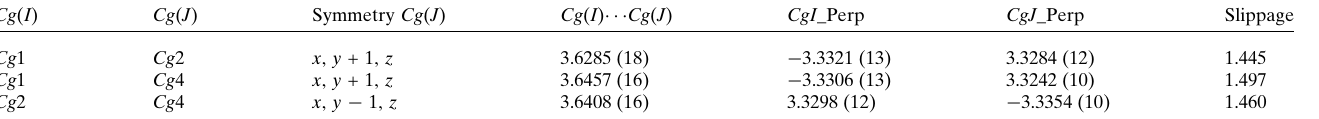
Table 2 Analysis of short ring interactions (A˚